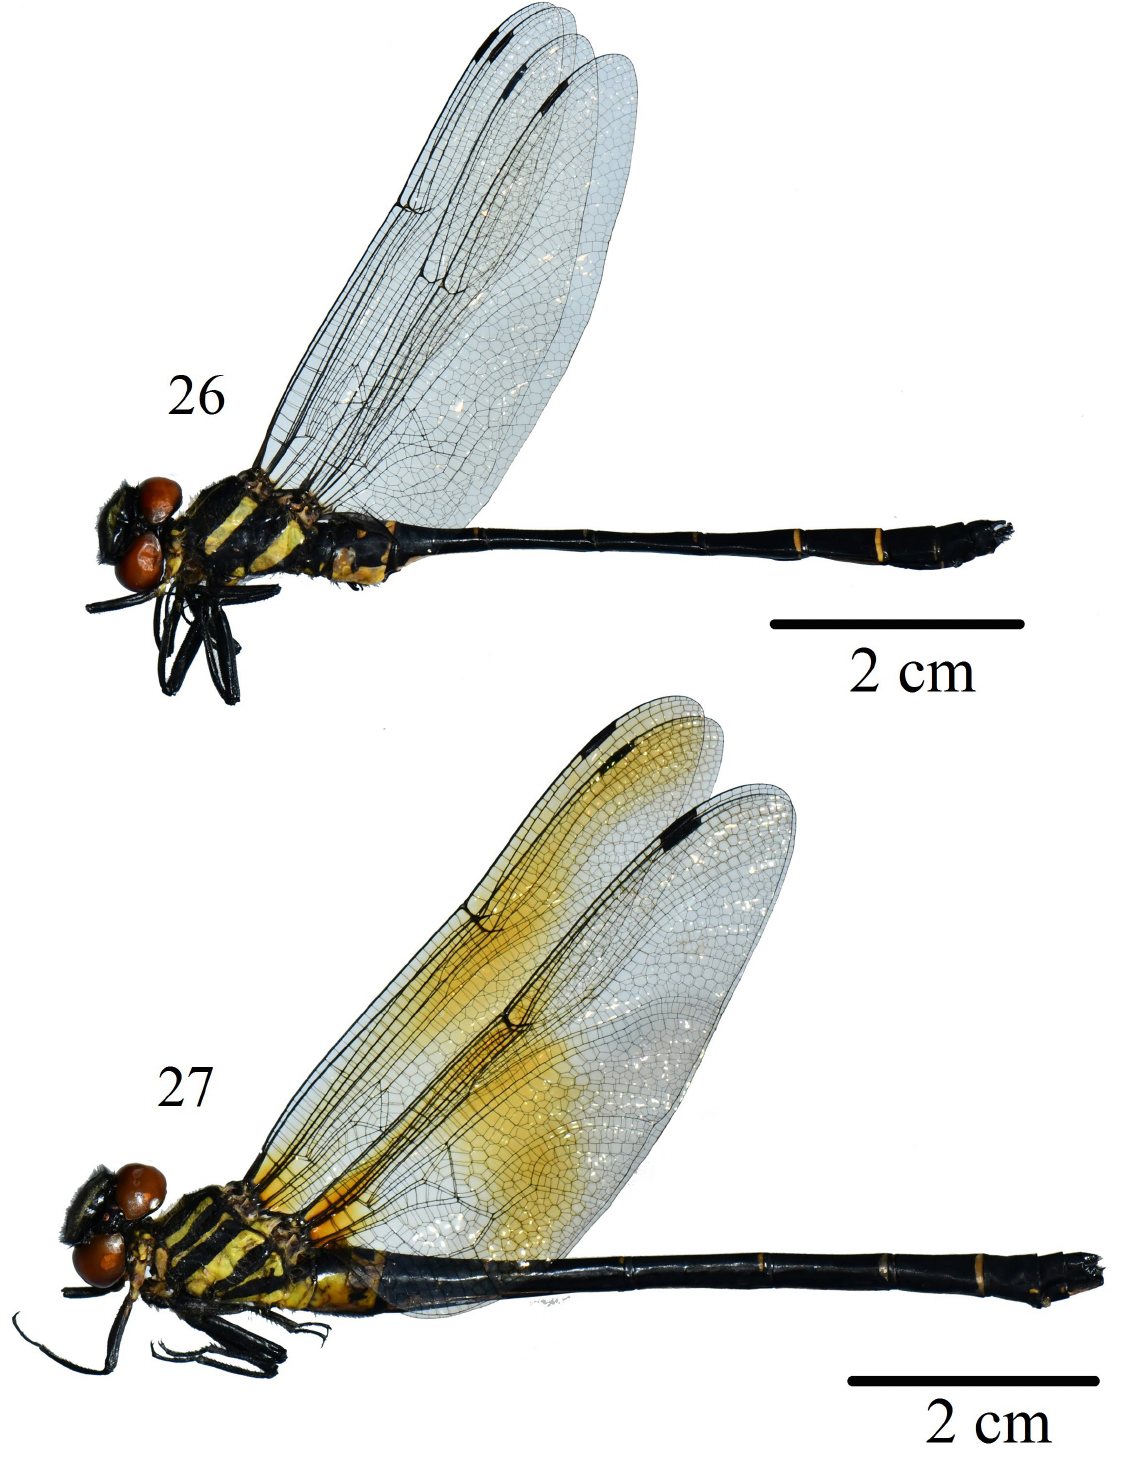
Figs 26–27. Habitus of Chlorogomphus vani sp. nov. 26 . Holotype, ♂ (ZCDTU 2021042001-ODO). 27 . Paratype, ♀ (ZCDTU